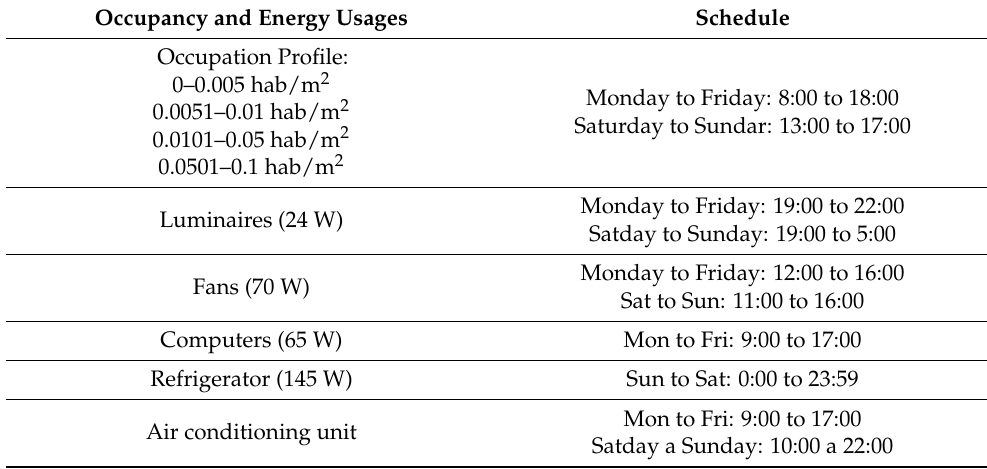
Figure 7. Population density in the urban zone (adapted from [8]). The studied zone inside black dashed square. Table 6. Occupied periods and energy usages in the urban zone [8].